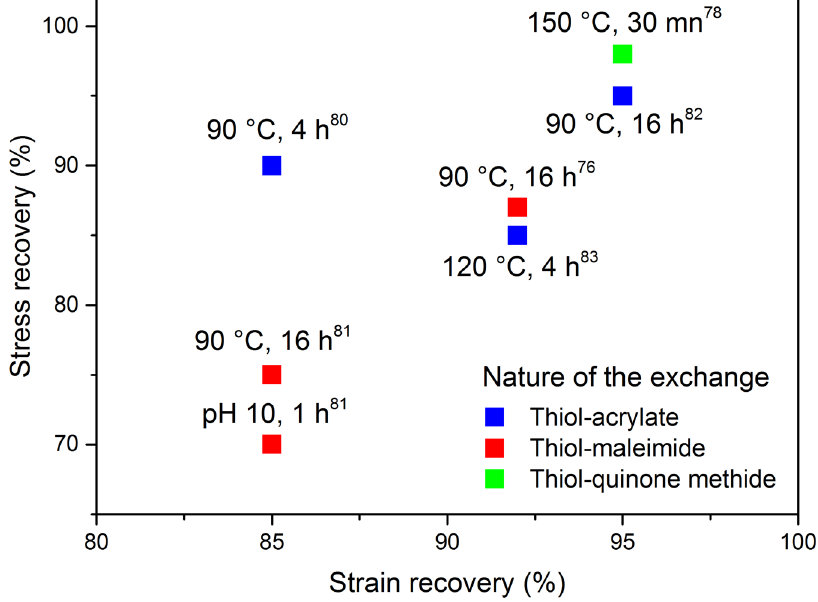
Figure 1. Strain and recovery percentages according to the nature of the exchange and the reprocessing conditions.